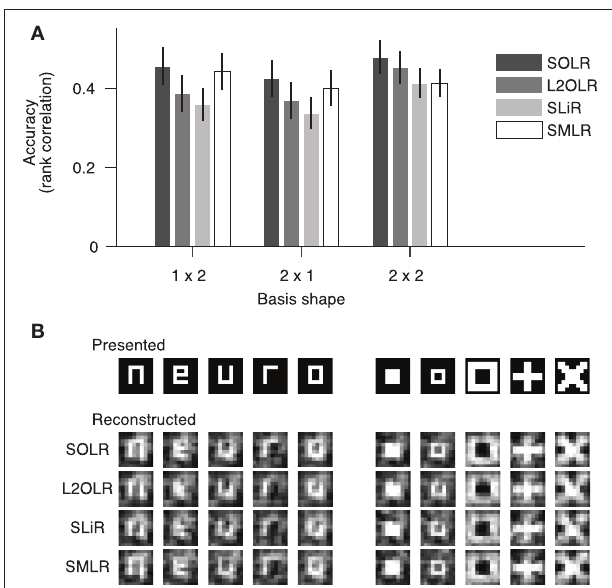
FIGURE 4 | Performance on visual image reconstruction data. (A) Prediction of mean contrasts of image bases. For each basis, the mean contrast was predicted by SOLR, L2OLR, SLiR, and SMLR. Performance was evaluated using the Spearman rank correlation between true and predicted mean contrast values across test samples. The mean performance averaged across basis locations is shown. Error bars show the 95% confidence intervals across basis locations. (B) Reconstructed images. Presented images and images reconstructed with the four algorithms are